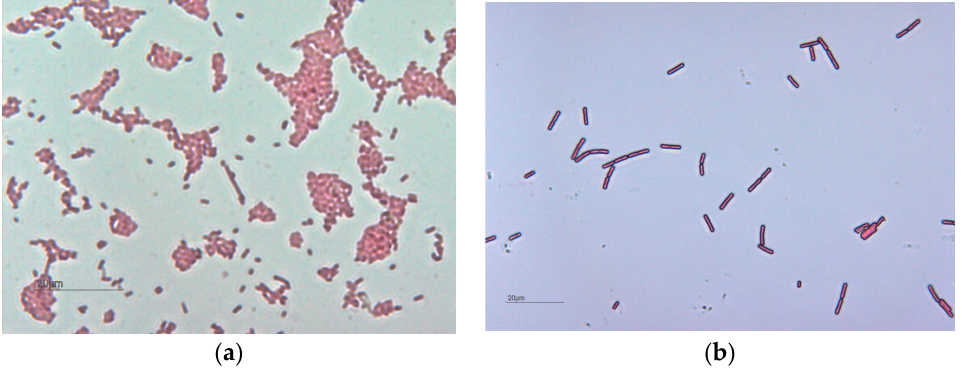
Figure 3. Microscopic observation (×1000 magnification) of ( a ) isolate 5.6 G − and ( b ) isolate 5.1 G+ observed in mine drainage water of Horná Ves tunnel (Central Slovakian neovolcanites).